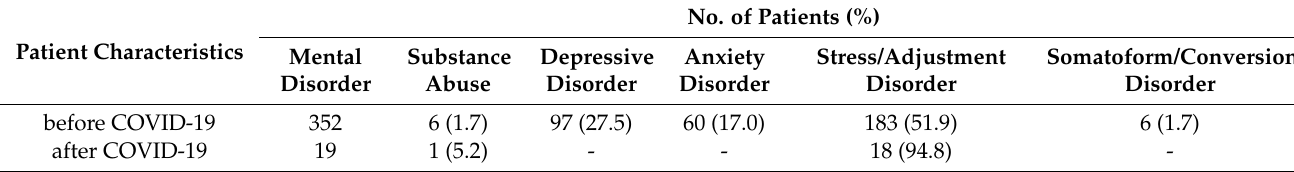
Table 2. Mental disorder before COVID-19 and post COVID-19 ( n =